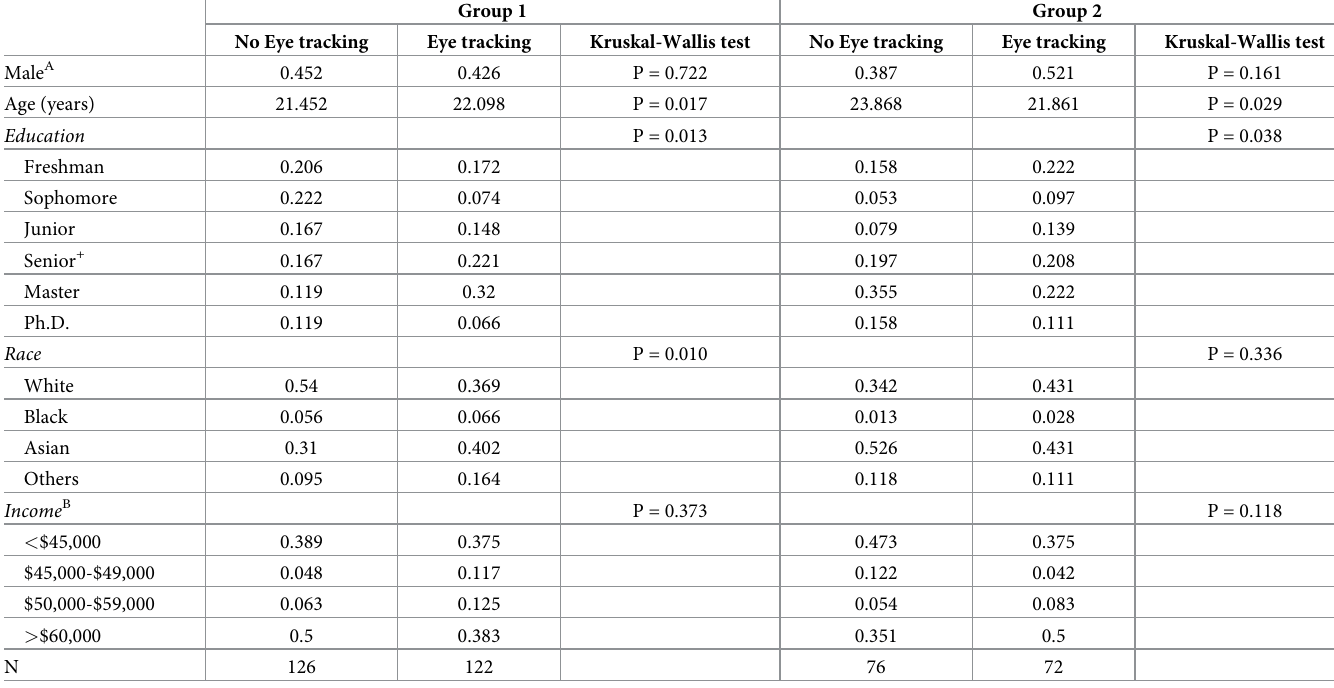
Table 2. Demographic balance test across